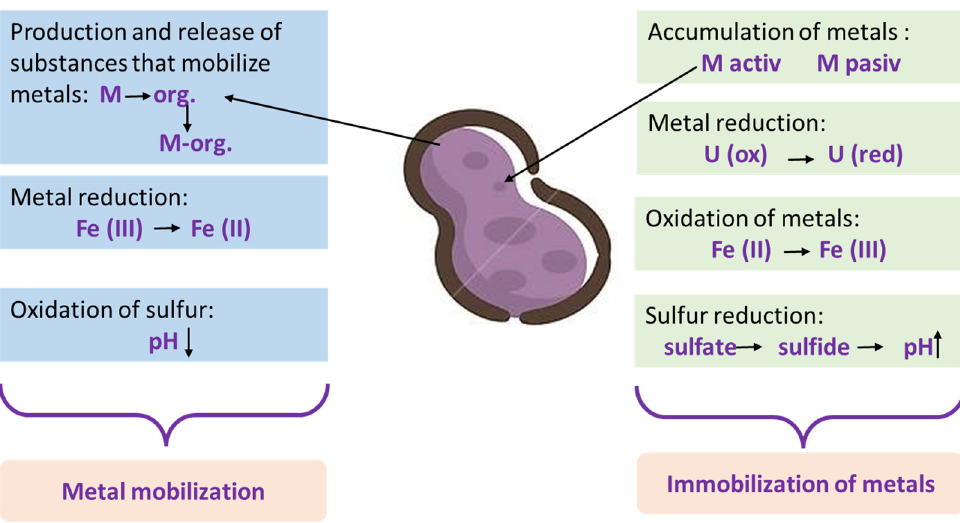
Figure 1. Interactions between metals and microorganisms.